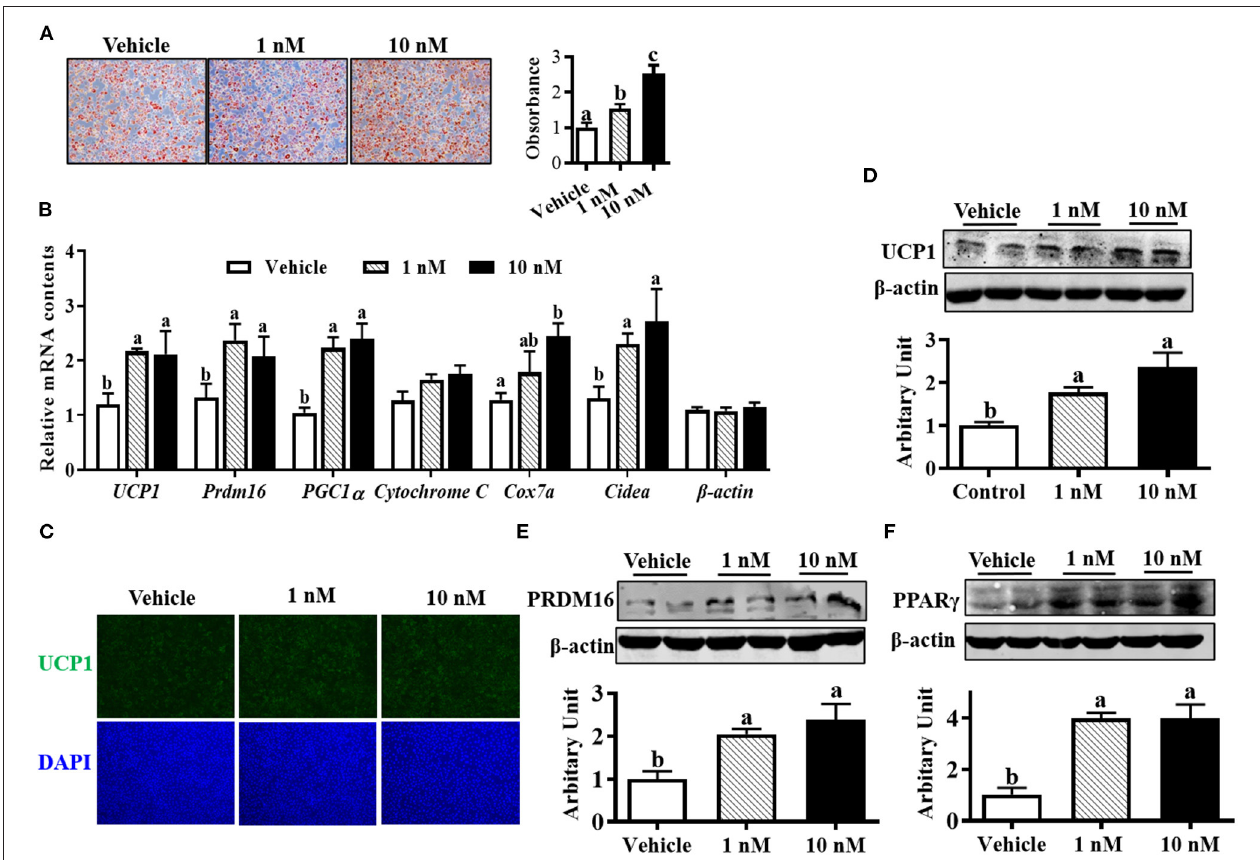
FIGURE 2 | Melatonin promoted brown adipocyte formation. (A) Cells were induced to brown adipogenesis for 6 days with or without melatonin (1 and 10nM), and adipocytes were visualized by oil-red O staining (100 × magnification). (B) Relative mRNA expression of brown adipogenic markers. (C) Immunocytochemistry staining of UCP1 after 6 days of differentiation. (D–F) Protein abundances of UCP1, PRDM16 and PPAR γ ( n = 6, mean ± SEM; different letters mean significant difference).